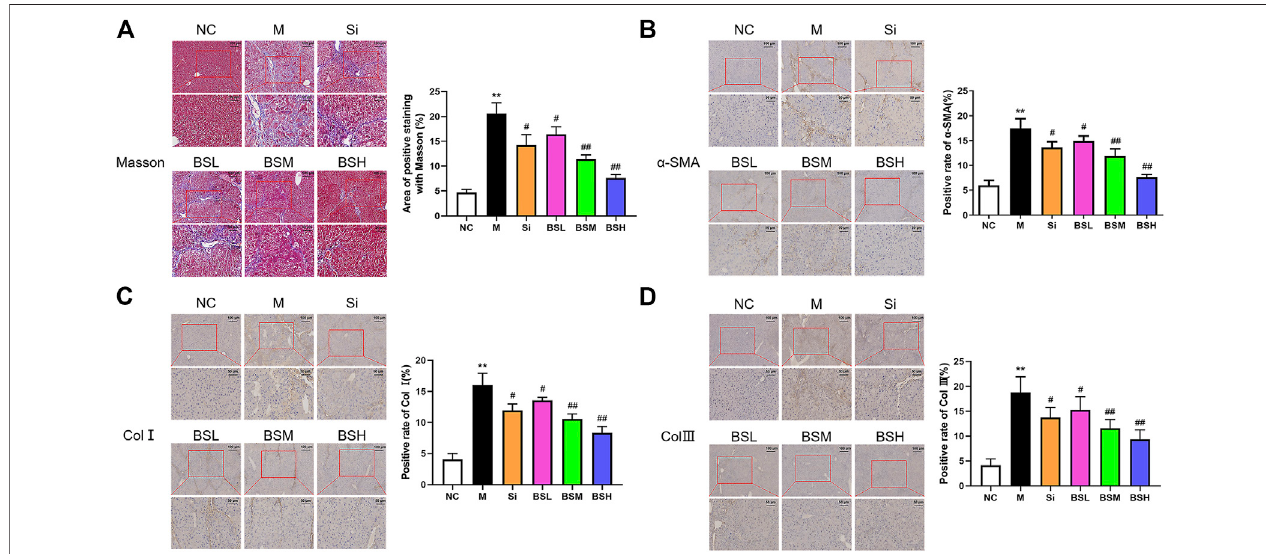
FIGURE8| BSameliorated the fi brosis-relatedbiomarkers invivo . (A) Masson ’ sstainingwasperformedon theliver tissues ofeach group. Representativeimages wereshown.Thepositiveareas ofMasson ’ sstainingwerecounted andcompared. (B – D) Immunohistochemicalanalysesfor α -SMA,ColI,orColIII wereconducted on thelivertissuesofeachgroup.Thepositiveareasof α -SMA,ColI,andColIIIwerecountedandcompared;scalebars (cid:2) 100 μ m,50 μ masindicated.Datawereshownas mean ± SD, n ≥ 3 and analyzed with the one-way ANOVA. ** p < 0.01 in the model group versus the control group. # p < 0.05, ## p < 0.01, Si, BSL, BSM, and BSH groups versus the model